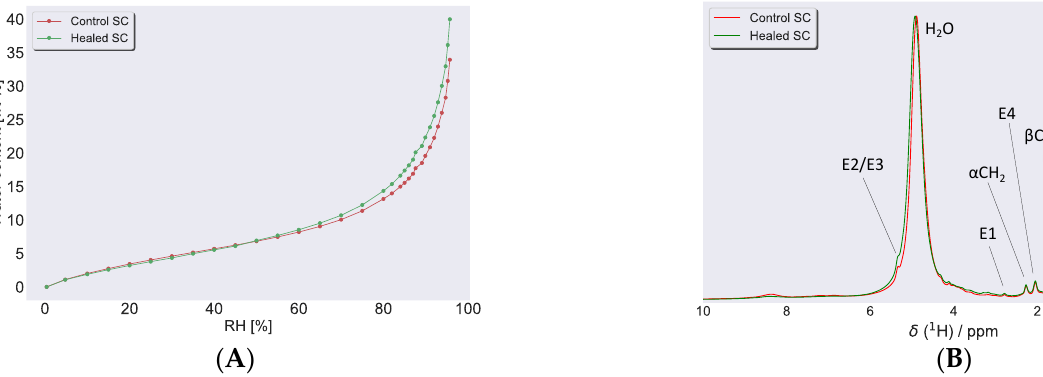
Figure 6. ( A ) Water sorption measurements for control and healed SC at 32 °C, expressed as water content, (in wt % with respect to dry SC) plotted as a function of RH. ( B ) 1 H NMR spectra recorded on control and healed SC at 97% RH. The peak close to 5 ppm in both spectra was due to water in the sample from hydration at 97% RH. Several sharp peaks attributed to lipid molecular segments (assignments in Figure 7E) were also detected, indicative of fluid lipids present in both samples. The arrow close to 0 ppm in the healed SC was due to the silicon present in the wound dressing.